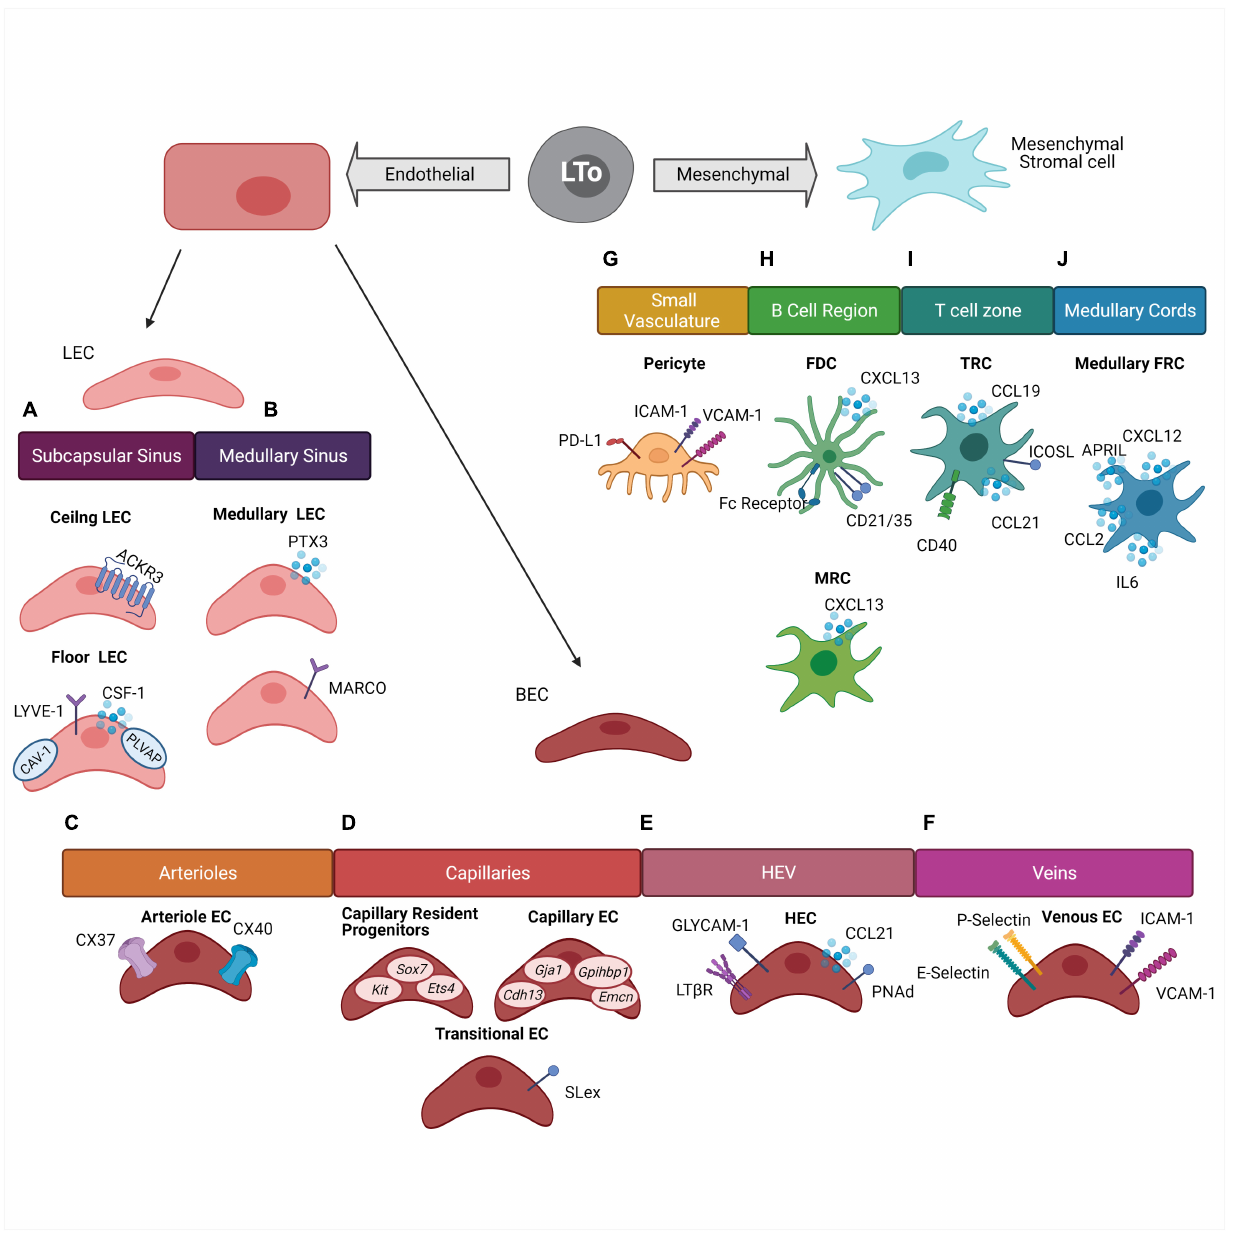
Frontiers in Cell and Developmental Biology |